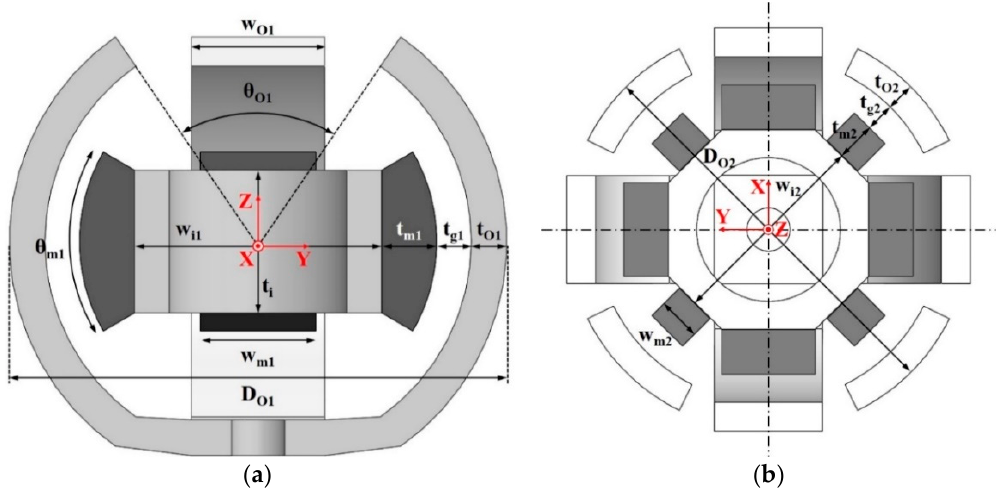
Figure 3. Design parameters of original 3-DOF spherical motor: ( a ) Y-Z and ( b ) X-Y cross-section. Table 2. Values of design parameters of original 3-DOF spherical